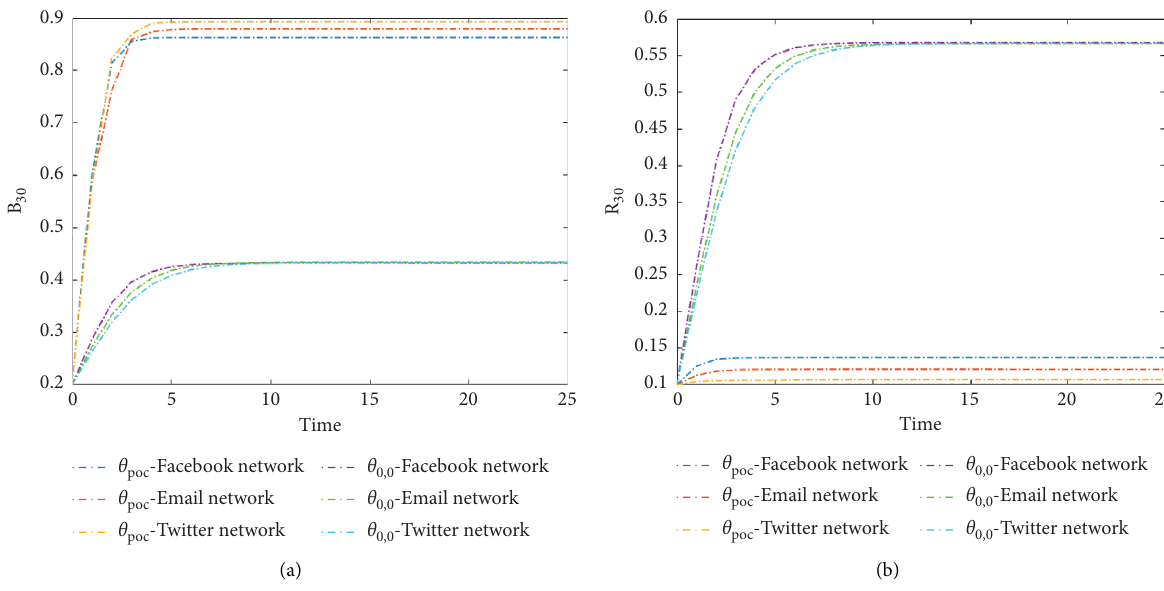
and without control θ poc